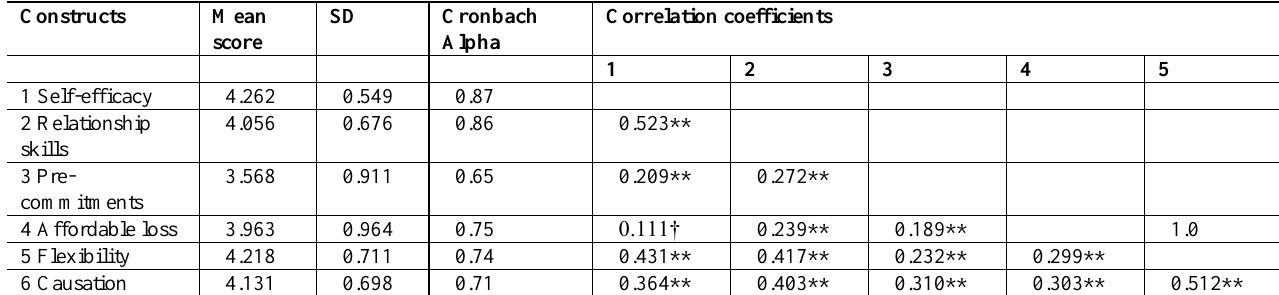
Table 3: Descriptive statistics